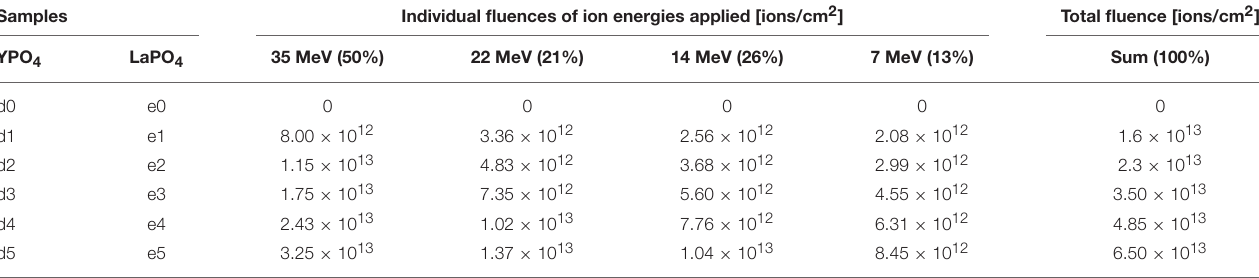
TABLE 1 | Detailed Au-irradiation plan as applied to YPO 4 and LaPO 4 ceramics. Samples